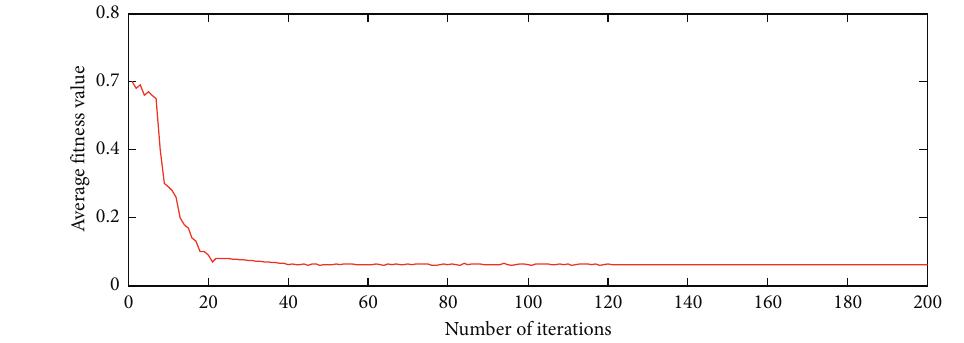
Figure 4: Schematic diagram of time series symbolization. (a) Original C . (b) Standardized C ’. (c) Dimensionality reduction C . (d) Symbolized 􏽢 C